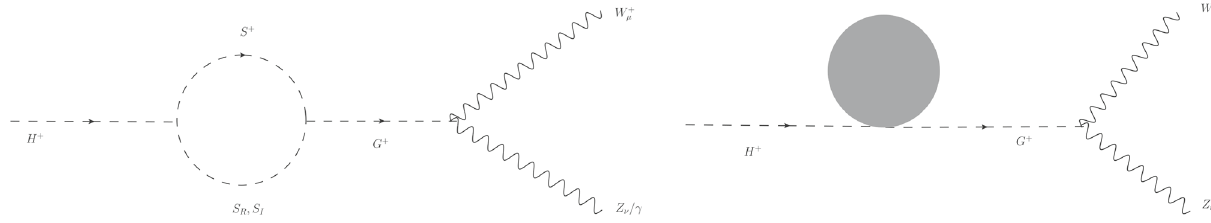
Fig. 3 Set C of one-loop amplitudes